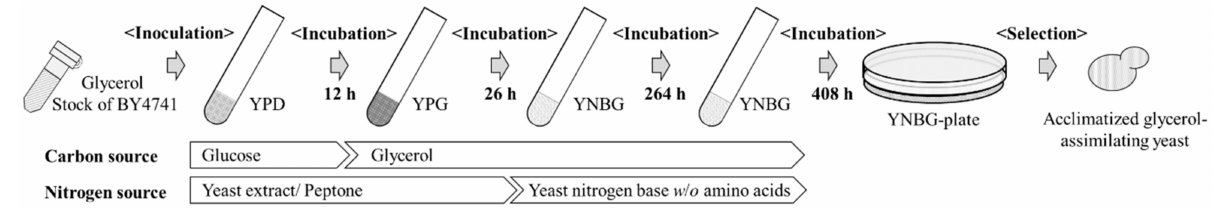
Figure 1. Overview of picking up glycerol acclimatized strains. BY4741 strains were acclimatized to glycerol assimilation gradually by nutrient